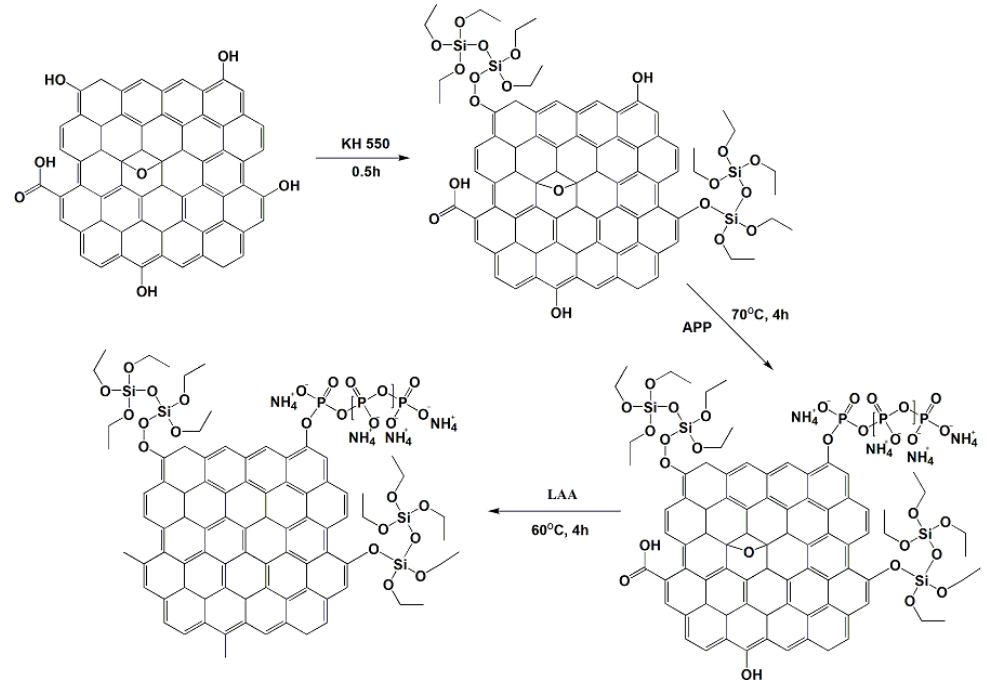
Figure 1. Synthesis route of RGO-APP flame retardant.